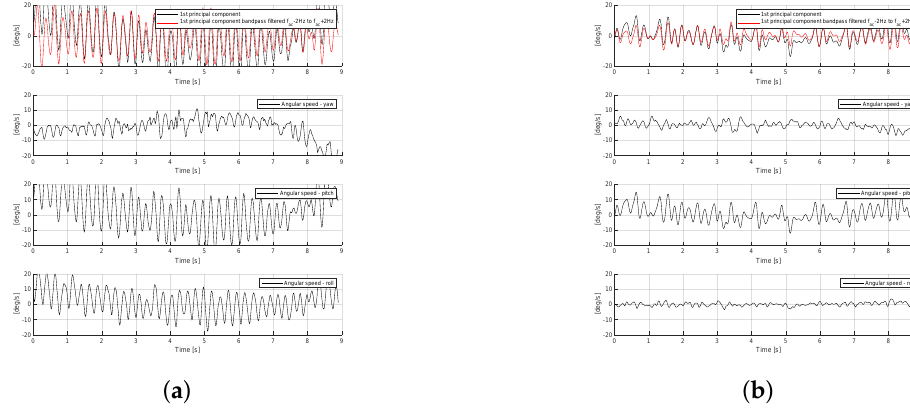
Figure 12. Gyroscope signal measured at the head of patients with essential tremor and cervical dystonia. ( a ) Patient-107, with essential tremor (from A2 group); ( b ) Patient-48, with cervical dystonia (from B2